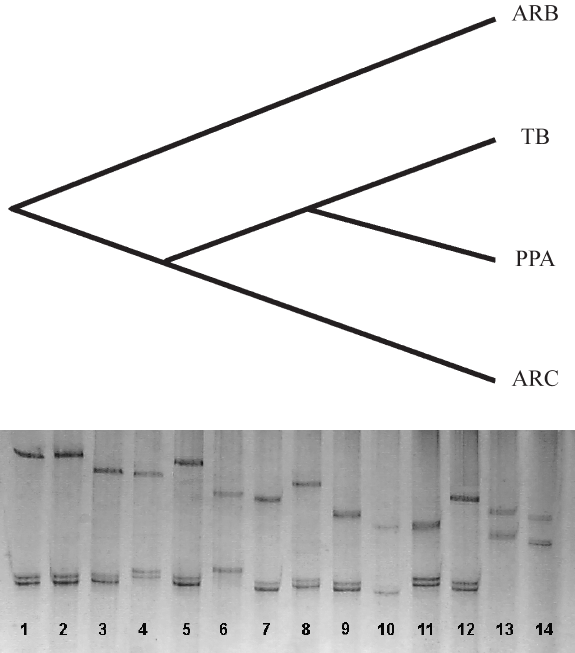
Figure 1 - A. Silver stained polyacrylamide gel showing the 14 SSCP variants detected in this study. B. Tree obtained with the Wagner parsi- mony method. ARC, Argentinean Creole; TB, Thoroughbred; PPA, Peru- vian Paso from Argentina; ARB,